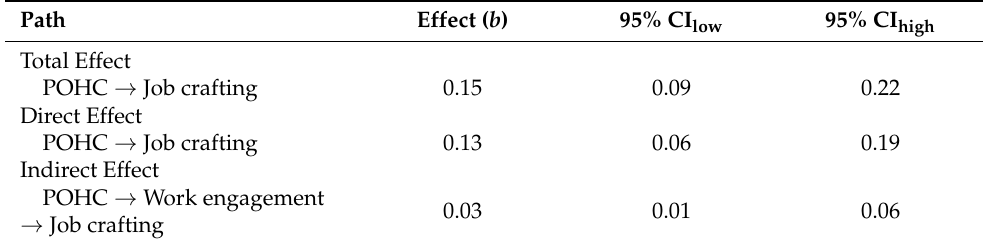
Table 3. Test of the mediating effect of work engagement on the POHC–job-crafting relationship.